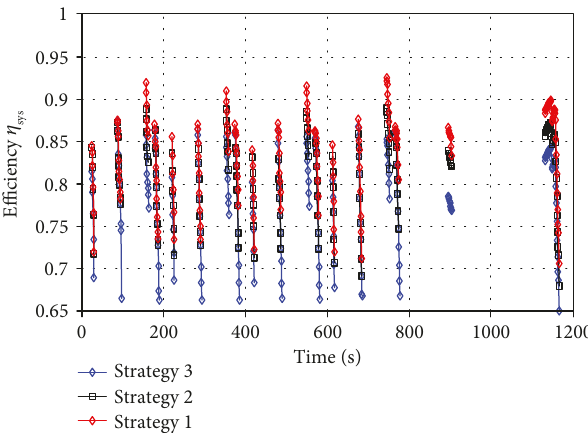
Figure 13: Utilization e ffi ciency of dual motors under cyclic condition.